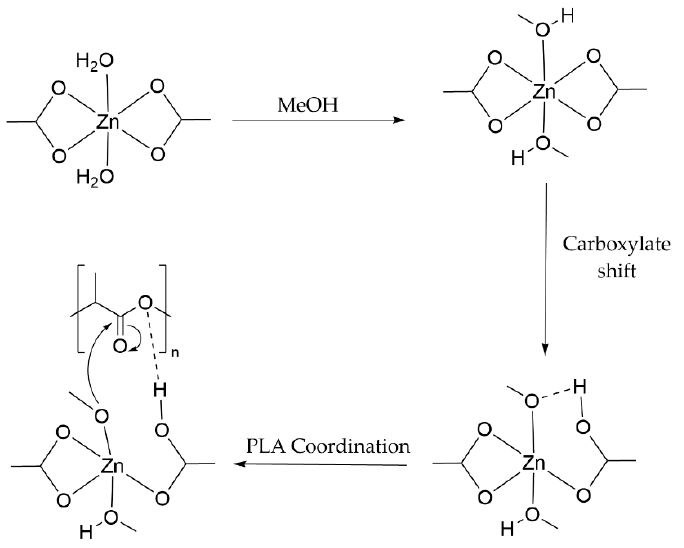
Figure 6. ZnAc coordination to methanol followed by a carboxylate shift and coordination to a PLA ester group during methanolysis, adapted from [46].